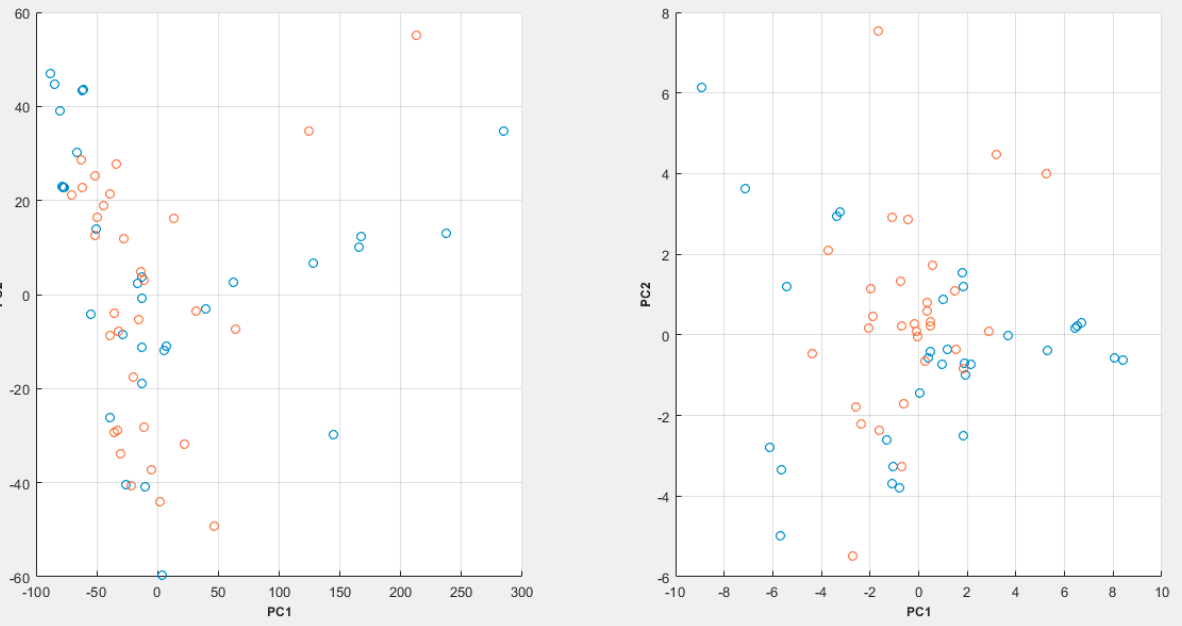
Figure 4. PCA plot for the raw spectroscopic data ( left ) and the LSDL decomposed data ( right ) with 98% variability explained (where blue = cancer samples, red = noncancer samples).